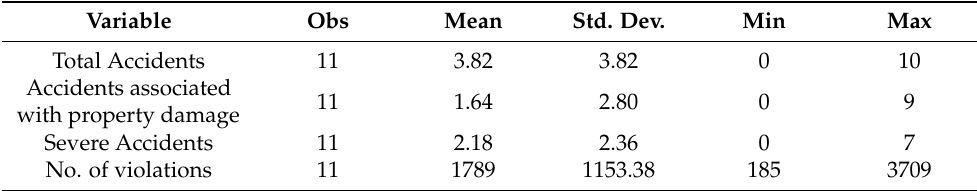
Table 2. 3-leg intersections summary statistics.